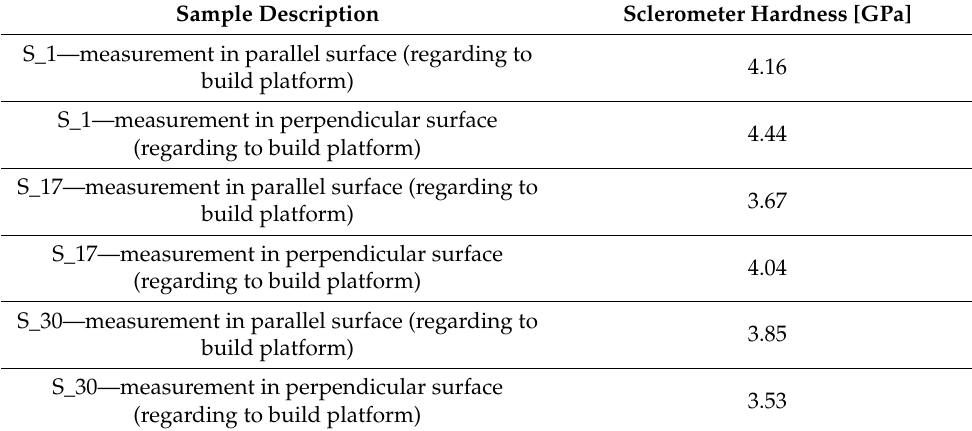
Table 3. Sclerometer hardness of samples S_1, S_17, and S_30 in both measured planes. Sample